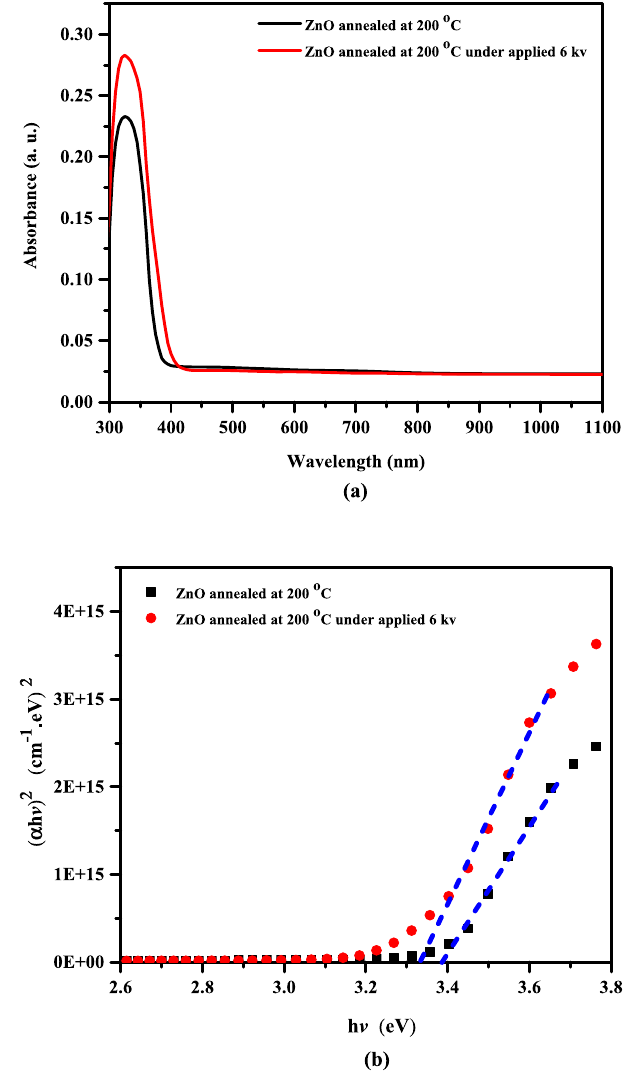
Figure 4. ( a ) Absorbance of ZnO thin films, ( b ) Plot of (αh v ) 2 versus hν for ZnO thin